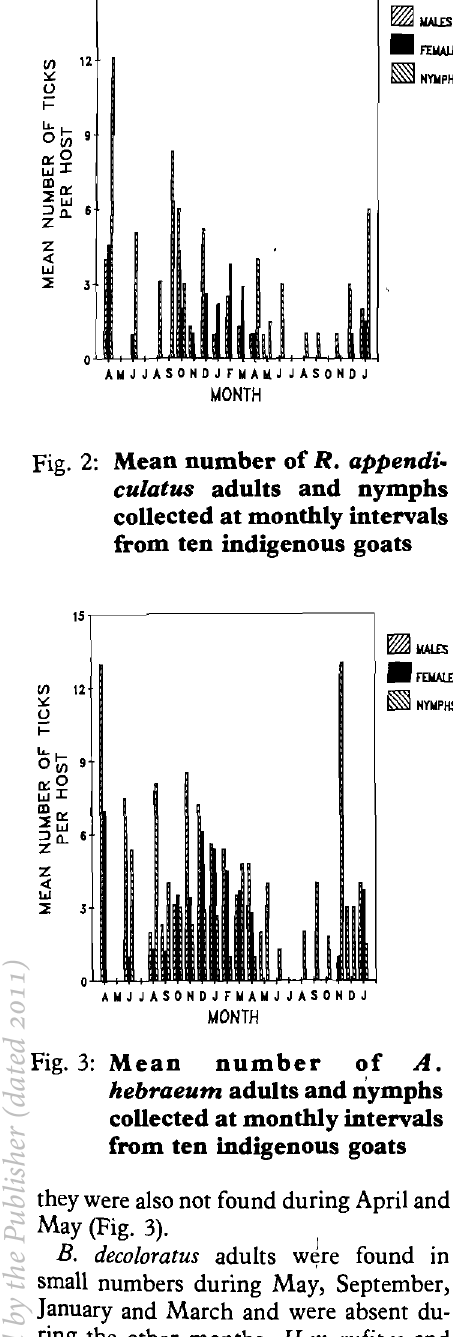
Fig. 3: Mean number of A. hebraeum adults and nymphs collected at monthly intervals from ten indigenous goats they were also not found during April and May (Fig.